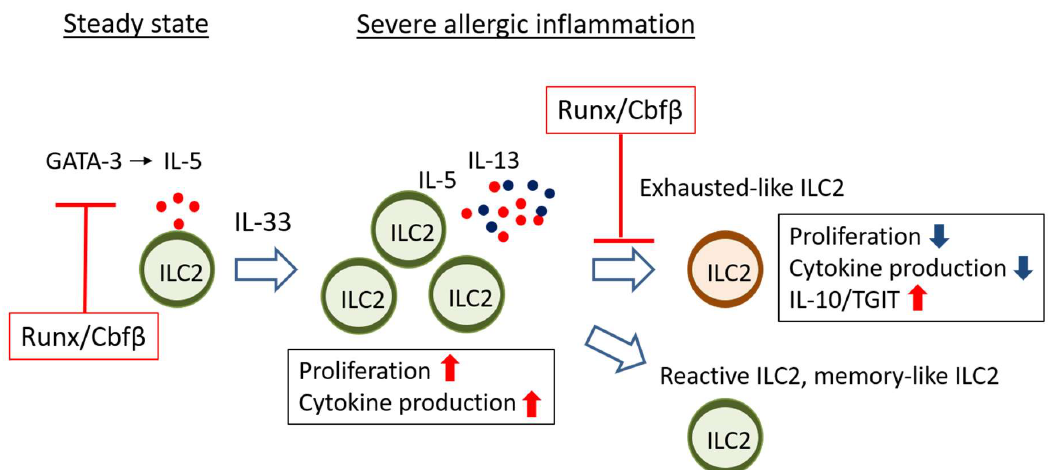
Figure 2. Runx/Cbfβ complexes differentially regulate ILC2 effector function at steady state and in severe inflammation. In the steady state of the lung, Runx/Cbfβ complexes suppress ILC2 activity through antagonistic binding to GATA-3 which positively regulates ILC2 effector function including constitutive IL-5 production (left red T-bar). During severe allergic airway inflammation, Runx/Cbfβ complexes are essential for ILC2s to respond to IL-33 and maintain their activity. Runx/Cbfβ complexes inhibit the emergence of exhausted-like ILC2s which are normally rare at the site of severe inflammation (right red T-bar). Red dots: IL-5. Blue dots: IL-13.